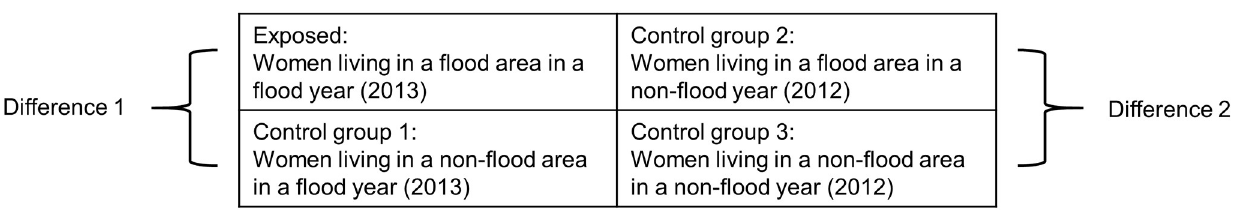
Fig 1. Conceptual framework for a difference in difference